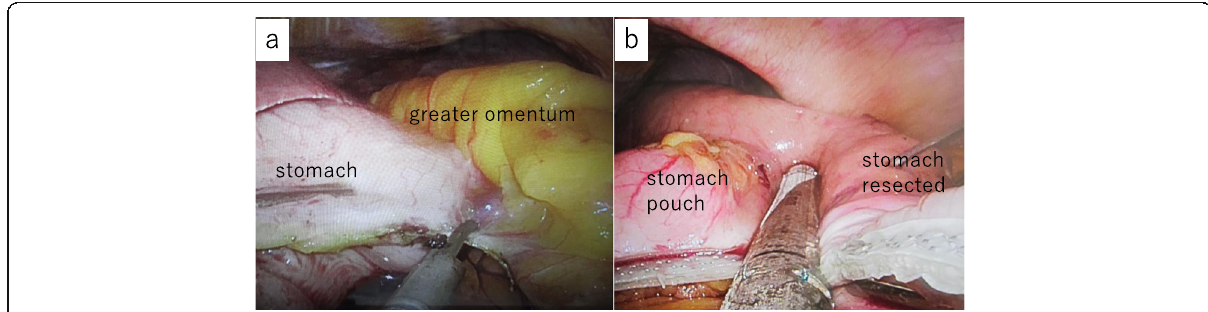
Fig. 2 Laparoscopic sleeve gastrectomy. a The greater omentum was dissected using a vessel-sealing system from a point located 4 cm from the pyloric ring (on the oral side) to the His angle. b The stomach was resected on the side of the greater curvature using a surgical stapling